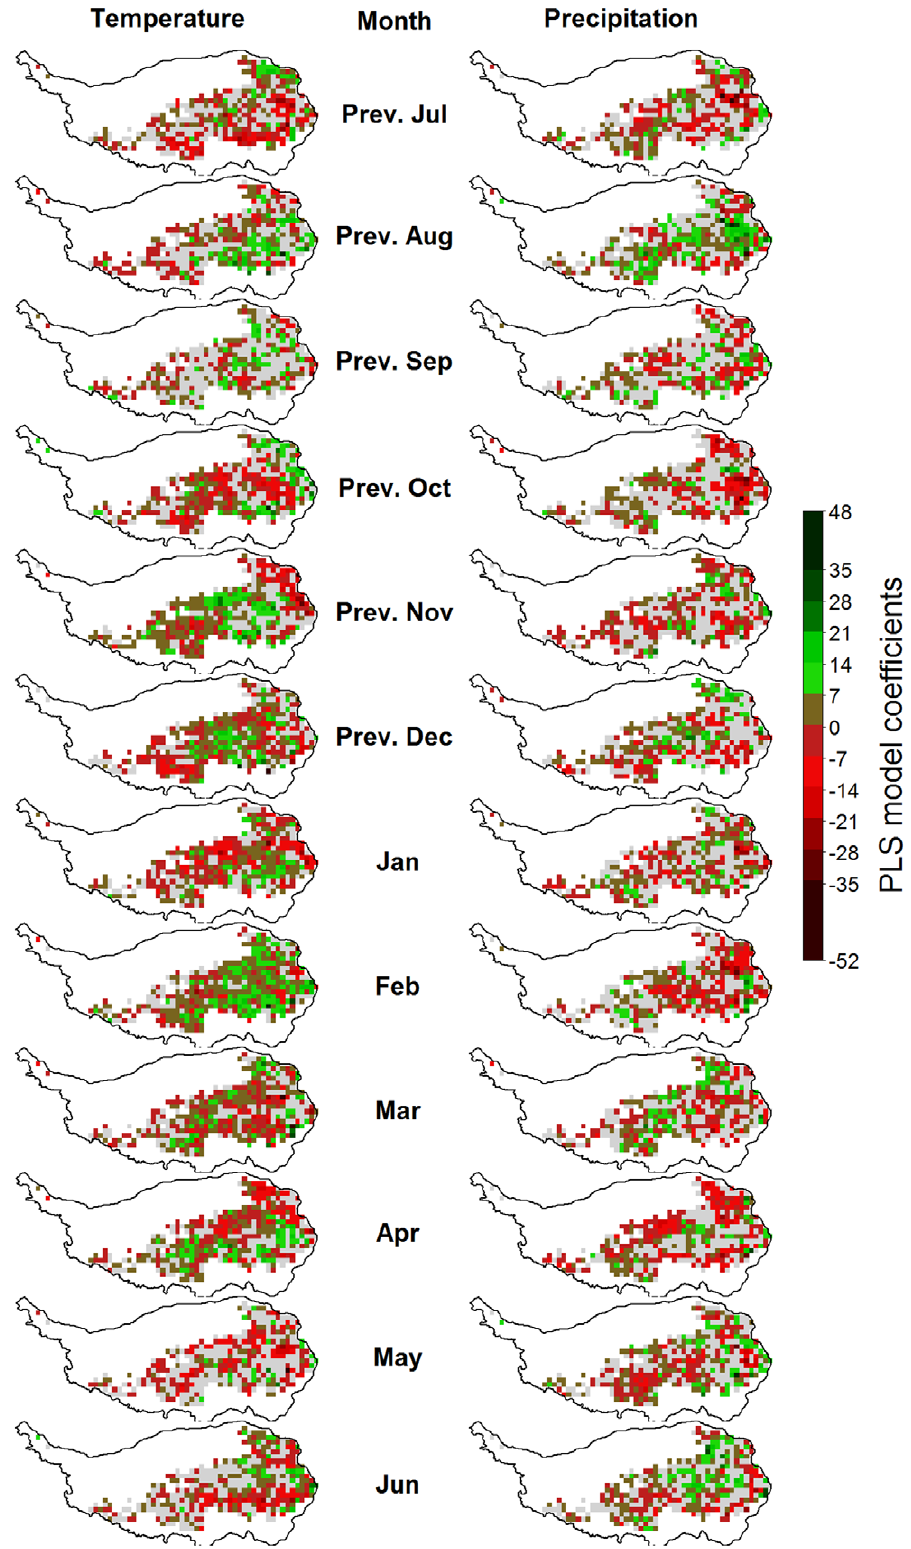
Figure 10. Correlations of monthly temperatures (left) and precipitation (right) with vegetation activity during the green-up phase (as measured by the NDVI) on the Tibetan Plateau, according to Partial Least Squares (PLS) regression. For each variable, pixels for which the variable-importance-in-the-projection score was , 0.8 are shown in gray. Pixels with insufficient data for PLS analysis are shown in white.